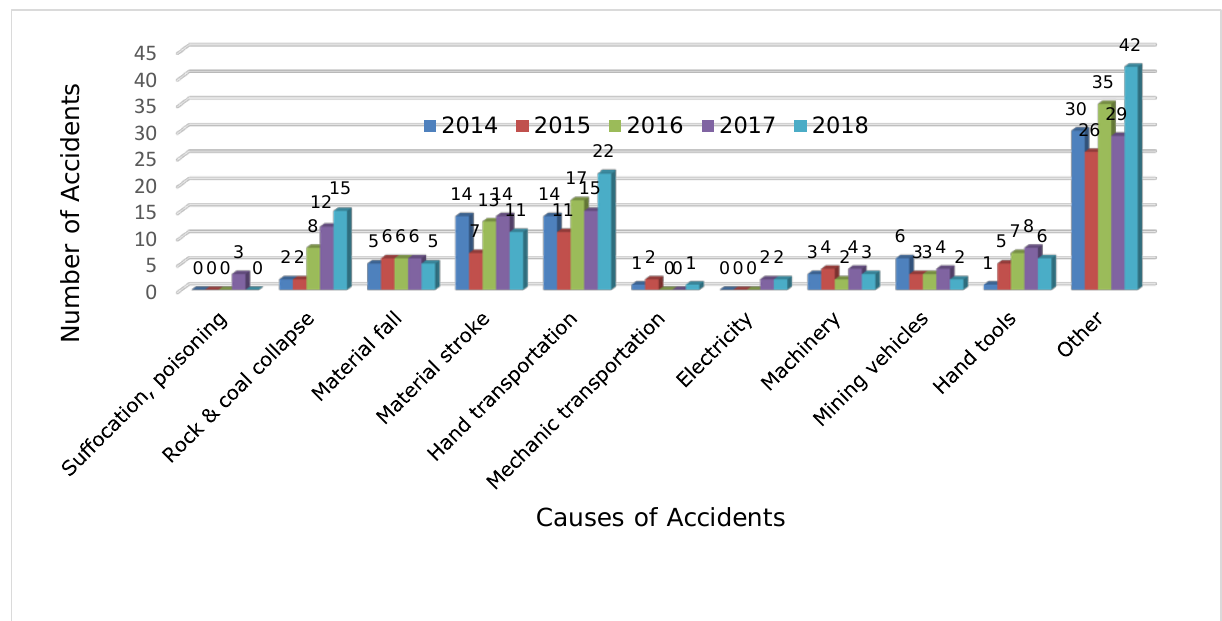
Figure 4. Number of Accidents between 2014 and 2018 by Causes of